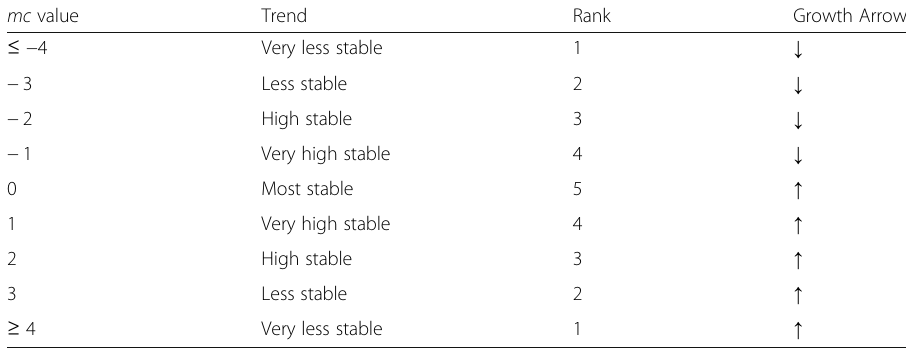
Table 3 Trend, rank and growth arrow for mc < 0 and mc ≥